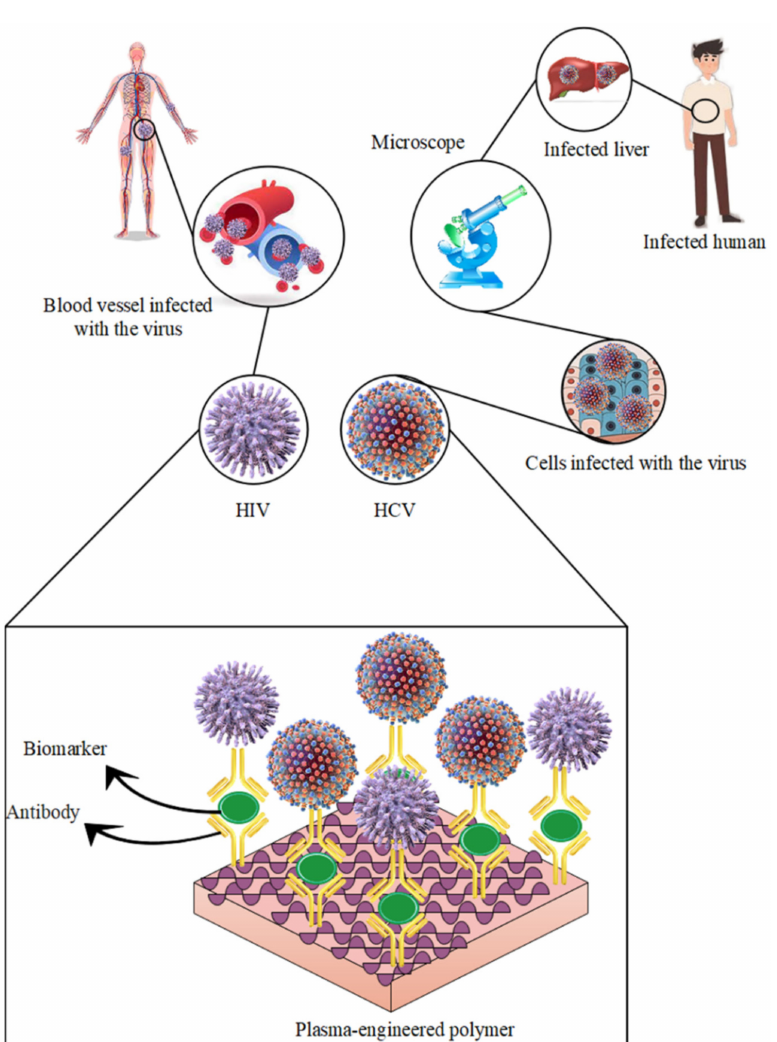
Figure 6. Detection of HIV & HCV by plasma-engineered polymer-based